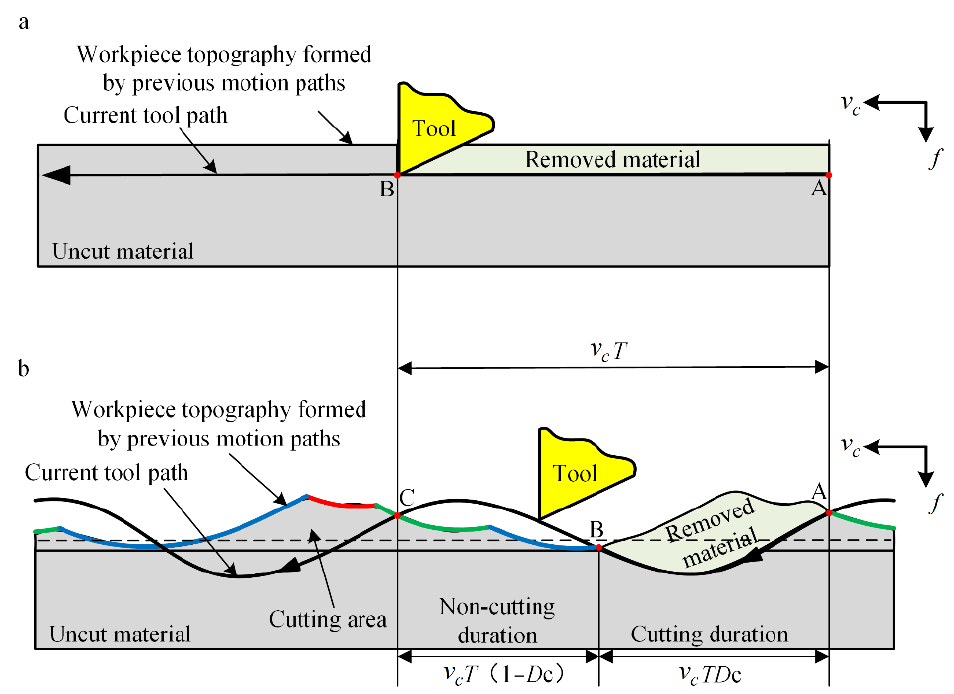
Figure 2. Schematics for comparison of ( a ) CC and ( b ) HUVC in one vibration cycle. v c , cutting speed, f , feed per revolution, T , ultrasonic vibration period, Dc , duty cycle.